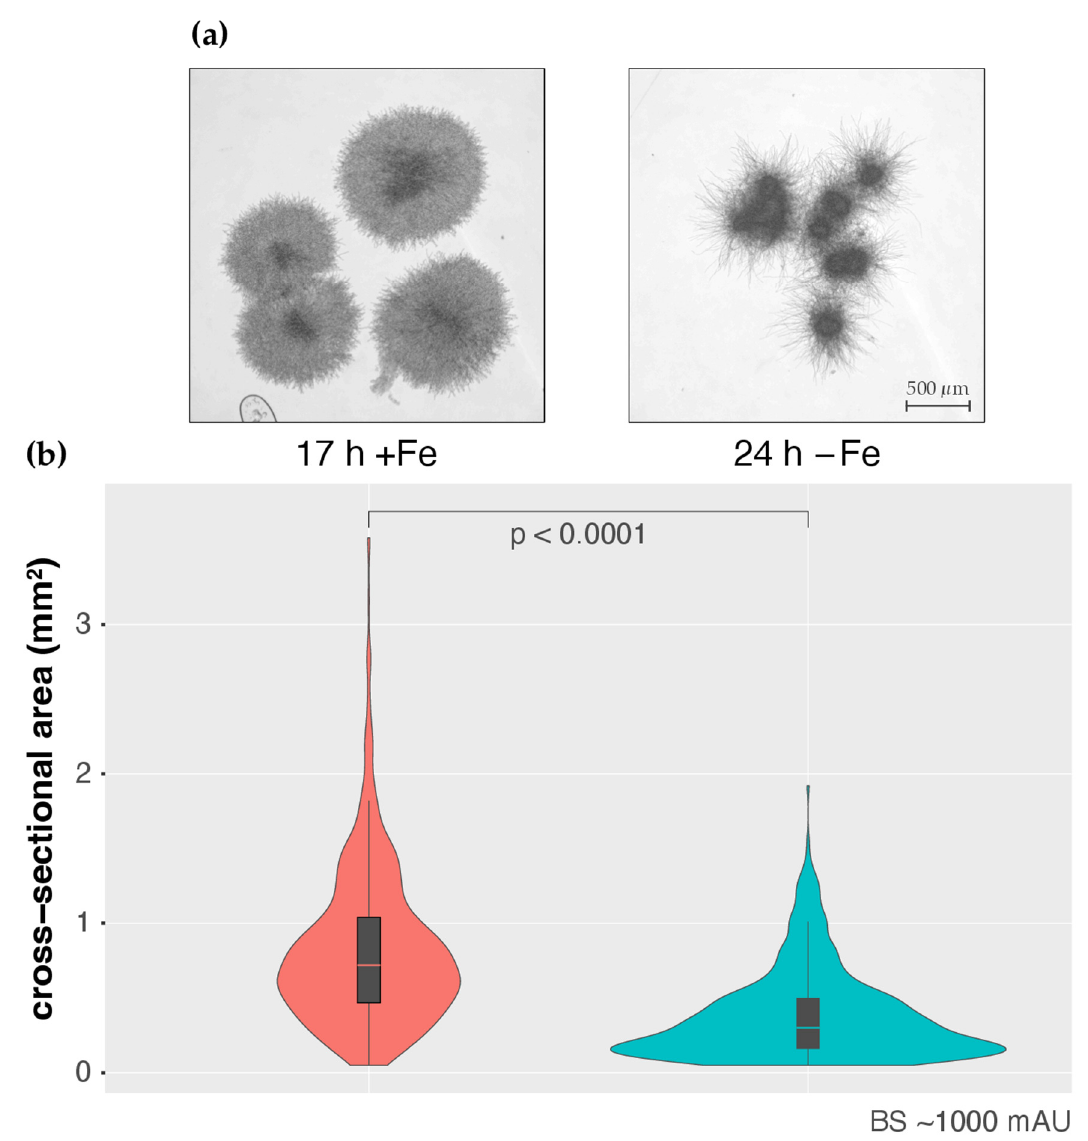
Figure 5. Pellet morphology differs in +Fe and − Fe conditions. ( a ) A. fumigatus AfS77 pellets were removed for microscopic analysis when base-line-corrected BS reached values of approximately 1000 mAU, after growth times of 17 h and 24 h for +Fe and − Fe conditions, respectively. ( b ) Violin plots showing the distribution of pellet cross-sectional area in +Fe and − Fe cultures at BS~1000 mAU. Box plots showing medians (0.72 mm 2 and 0.30 mm 2 for +Fe and − Fe, respectively), interquartile ranges, and spikes extending to the upper- and lower-adjacent values in each group are overlaid. Outliers are not